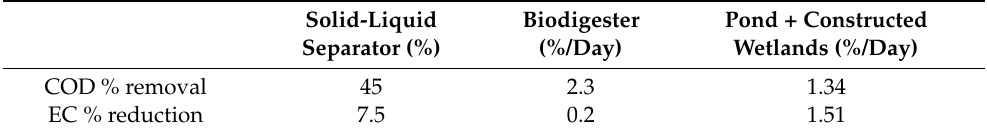
Table 3. COD % removal and EC% reduction of solid-liquid separator, biodigester and pond + constructed